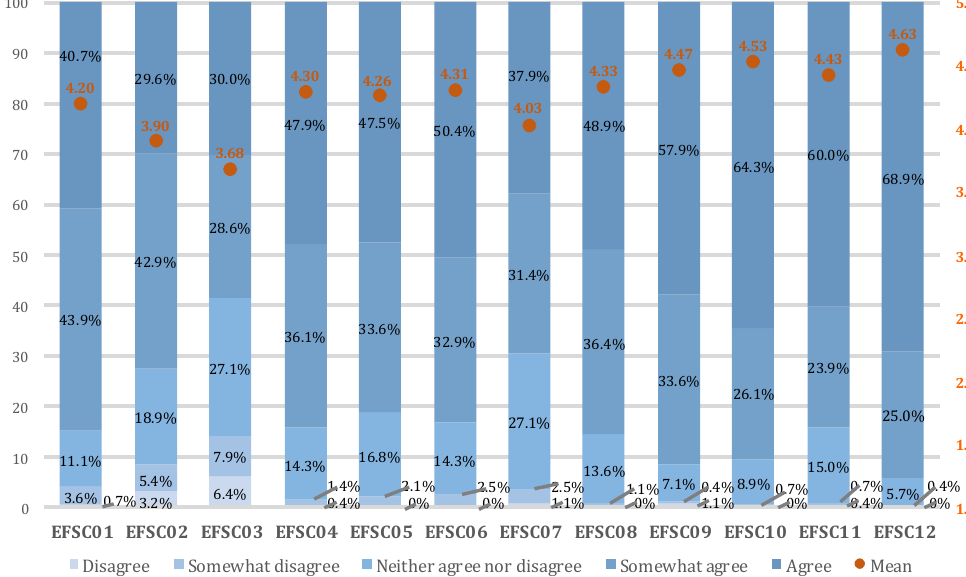
Figure 3. Perception of IEFS considered an integral element of SC by the surveyed cities.